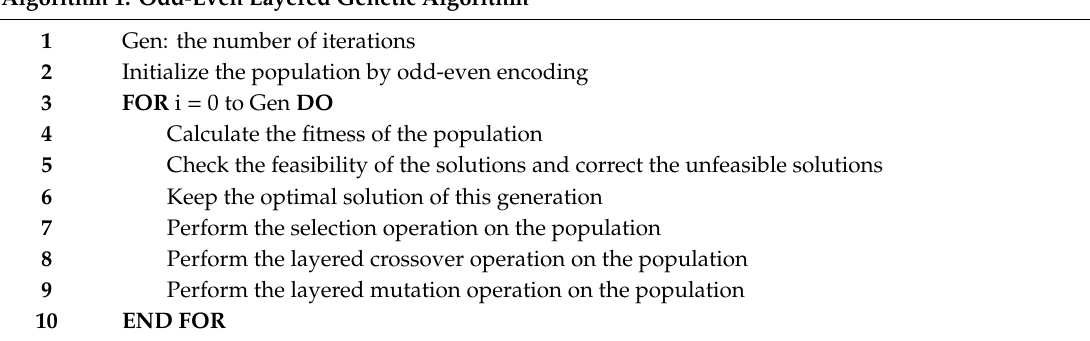
Algorithm 1: Odd-Even Layered Genetic